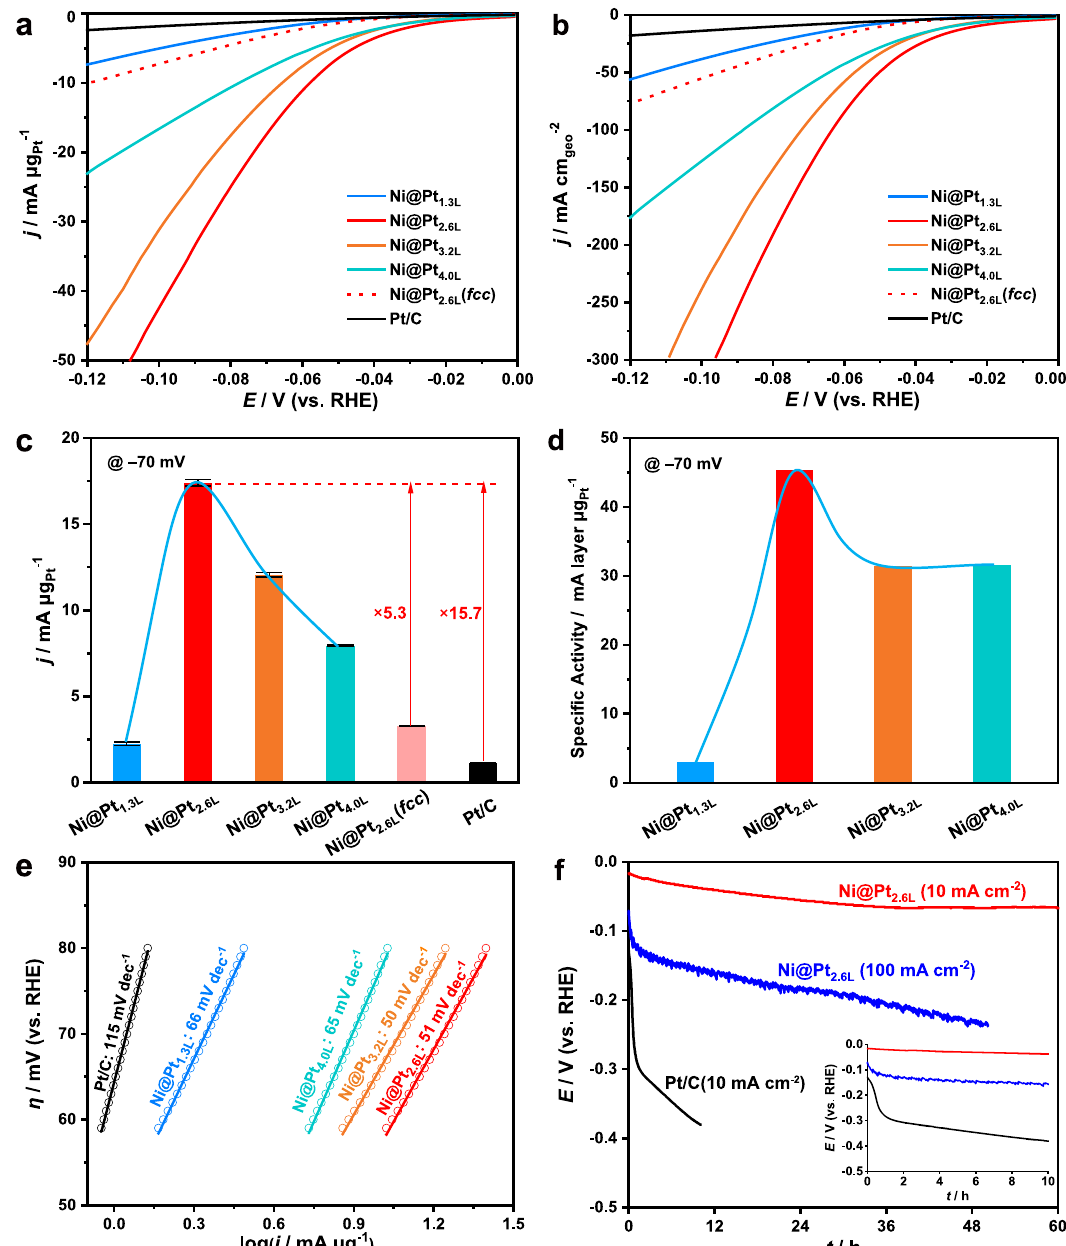
Fig. 4 | Electrocatalytic performance of the hcp -Ni@Pt-skin catalysts in the alkalineHER,comparedwith fcc -Ni@Pt-skinand thecommercialPt/C. a , b LSV curvesofthecatalystswith90% iR compensationinN 2 -saturated1MKOHatascan rateof10mVs – 1 .ThecurrentdensitiesarenormalizedtothemassofPt(1.5 µ g)and the geometric area of the electrode (0.196 cm 2 ), respectively. Solution resistances ( R ) were 6.237, 4.114, 5.293, 5.181, 3.604, and 3.399 Ω for measurements with